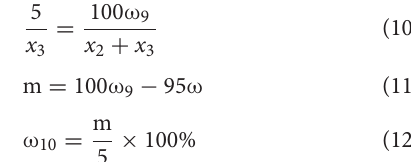
FIGURE 5 | Expansion rate of the cement with different MgO contents.